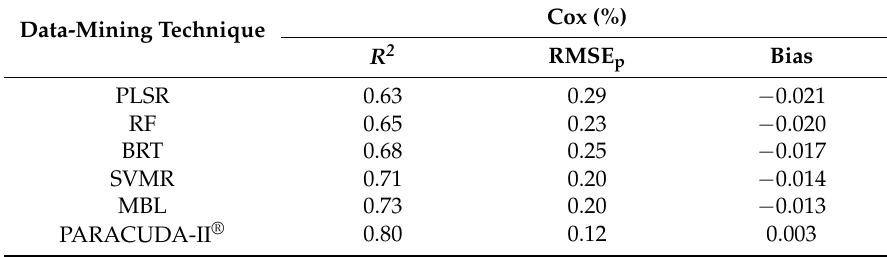
Table 2. Performance of Cox prediction on validation dataset using different data ‐ mining techniques.